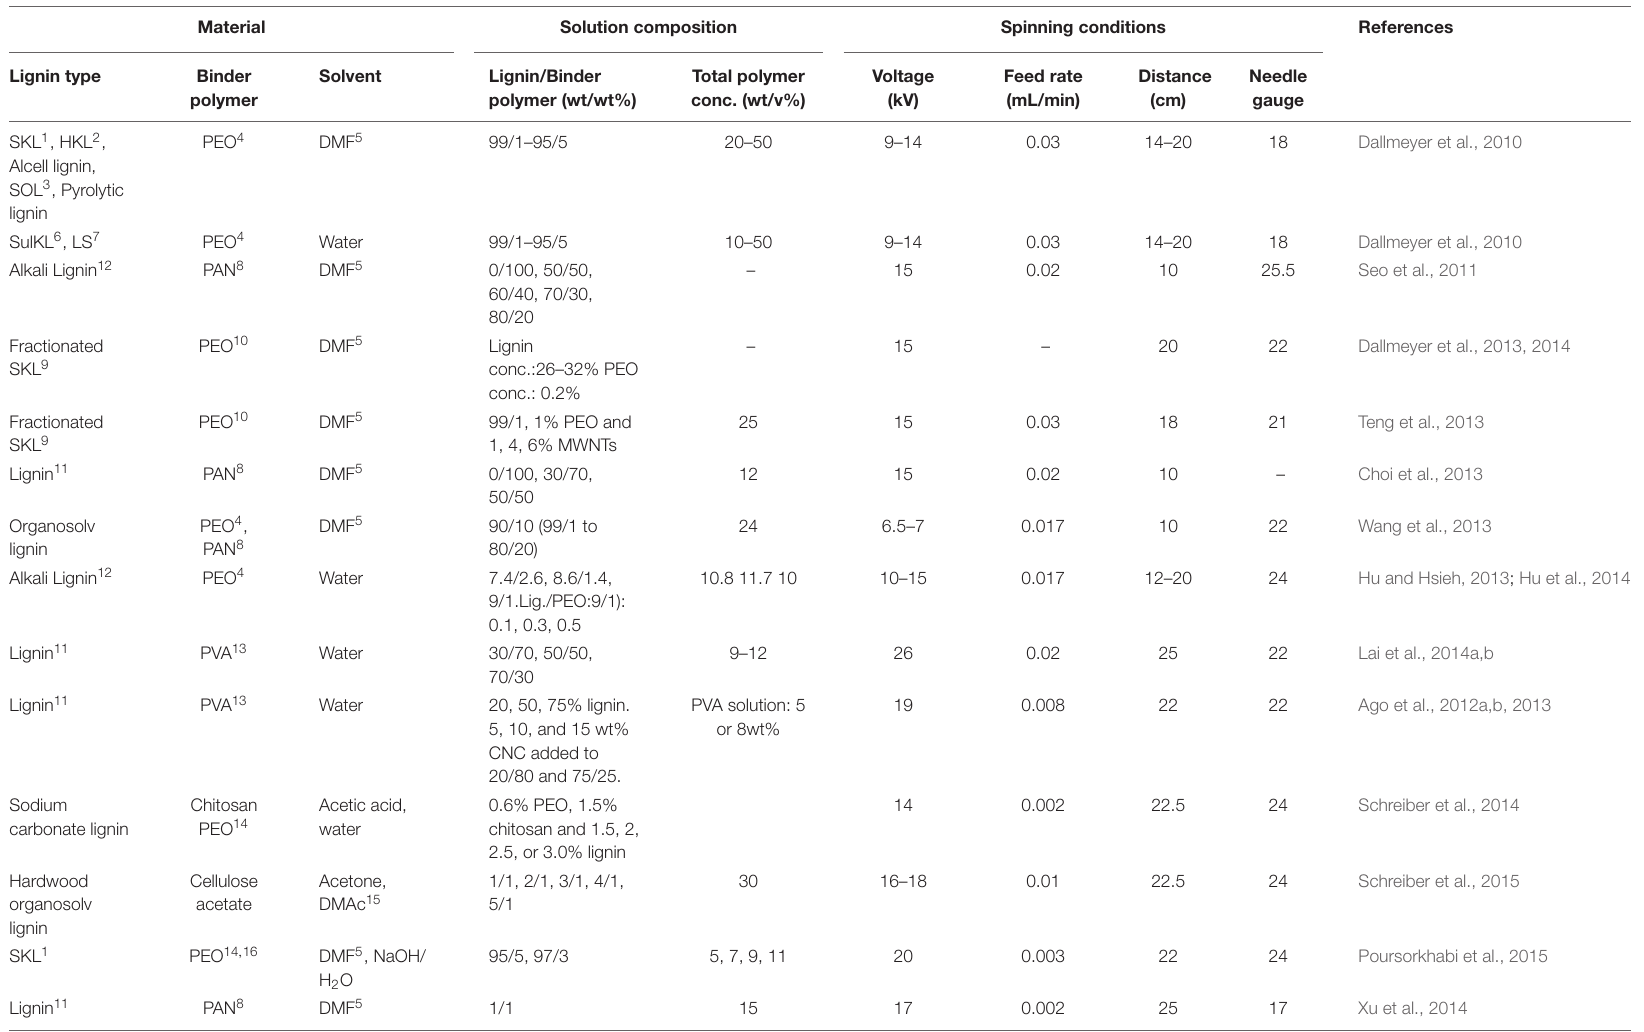
TABLE 1 | Solution composition and spinning conditions for electrospinning of lignin. Material Solution